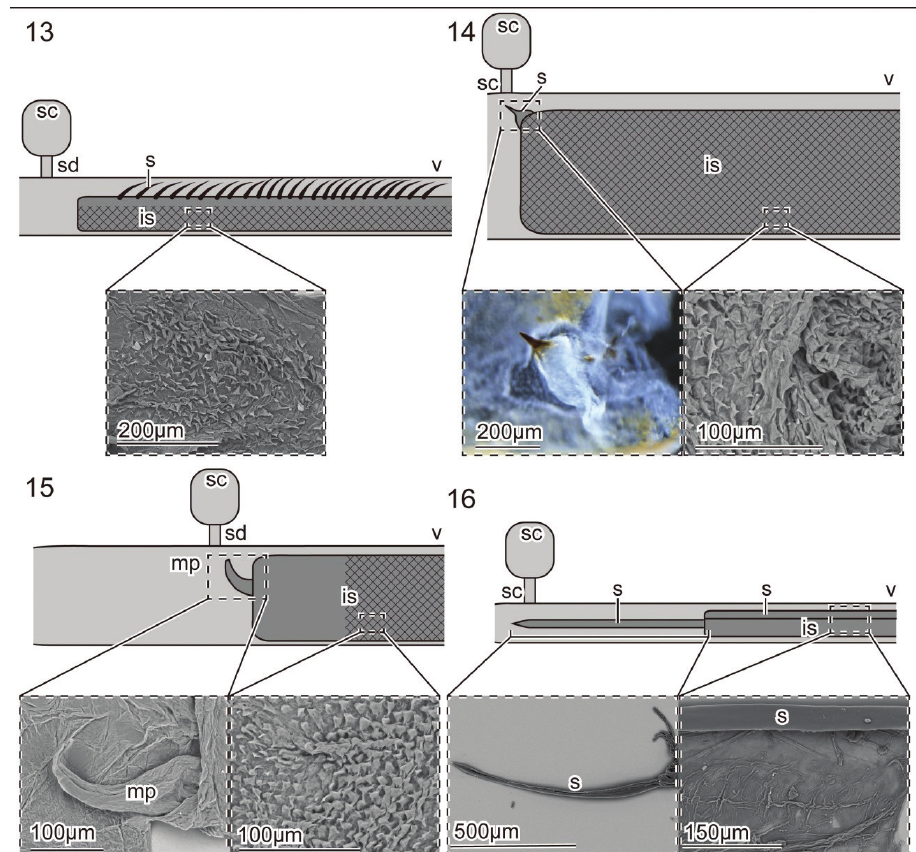
Figures 13–16. Schemes of hypothetical couplings between male and female genitalia, light microscopy (LM) and scanning electron microscopy (SEM) images of the male internal sac 13 Pyrrhalta maculicollis 14 P. tibialis 15 P. humeralis 16 Tricholochmaea semifulva species complex. The schemes were created using information on morphology and dimensions of both male and female genitalia, but the genital coupling has not been experimentally proven. The meshed areas in the male internal sacs show areas covered by tiny pro- jections, as shown in the SEM images. All samples were dried at room temperature. Abbreviations: is, inter- nal sac; mp, membranous projection; s, sclerite; sc, spermathecal capsule; sd, spermathecal duct; v,